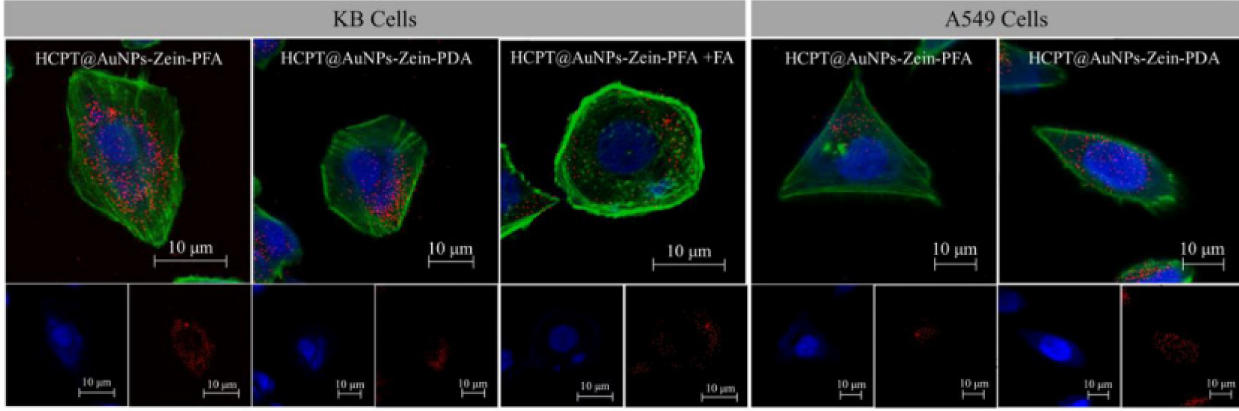
Figure 10. CLSM images of KB and A549 cells treated with HCPT-loaded NCs (HCPT@AuNPs Zein-PFA NCs in the presence of excessive free folate) at 37 ◦ C for 1 h. The plasma membranes of cells were stained green by Alexa Fluor 488 phalloidin. Their nuclei were stained blue by DAPI. Nanoparticles were labeled red with cy5. Reproduced with permission from [94], ELSEVIER,